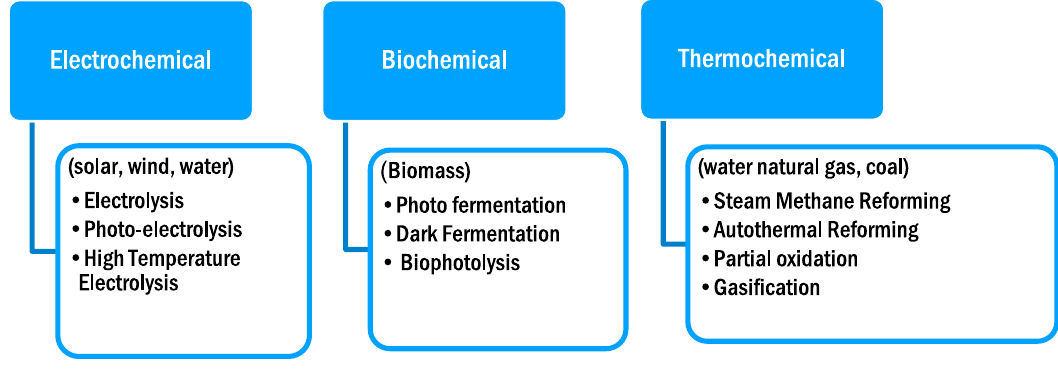
Fig. 1. Pathways of